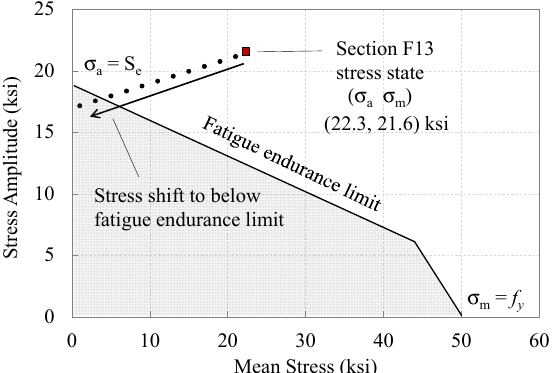
Figure 9. Modified Goodman life diagram with data points and the stress